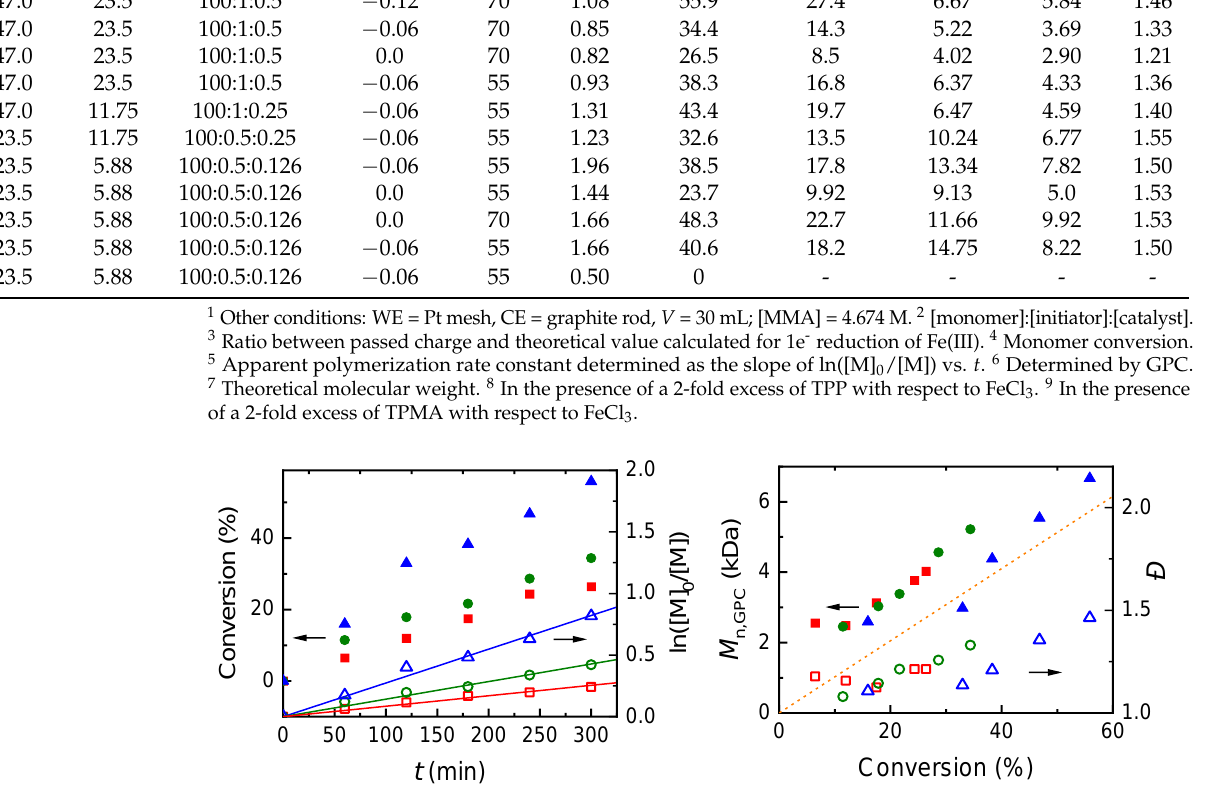
Figure 9. e ATRP of MMA mediated by FeCl 3 in DMF/MMA (50/50, V/V ) + 0.1 M Et 4 NBF 4 at 70 °C and E app = E 1/2 (squares), E app = E p − 0.06 V (circles), and E app = E p − 0.12 V (triangles). The dashed line stands for theoretical M n . Other conditions: [MMA]:[EBPA]:[FeCl 3 ] = 100:1:0.5 with [FeCl 3 ] = 23.5 mM.